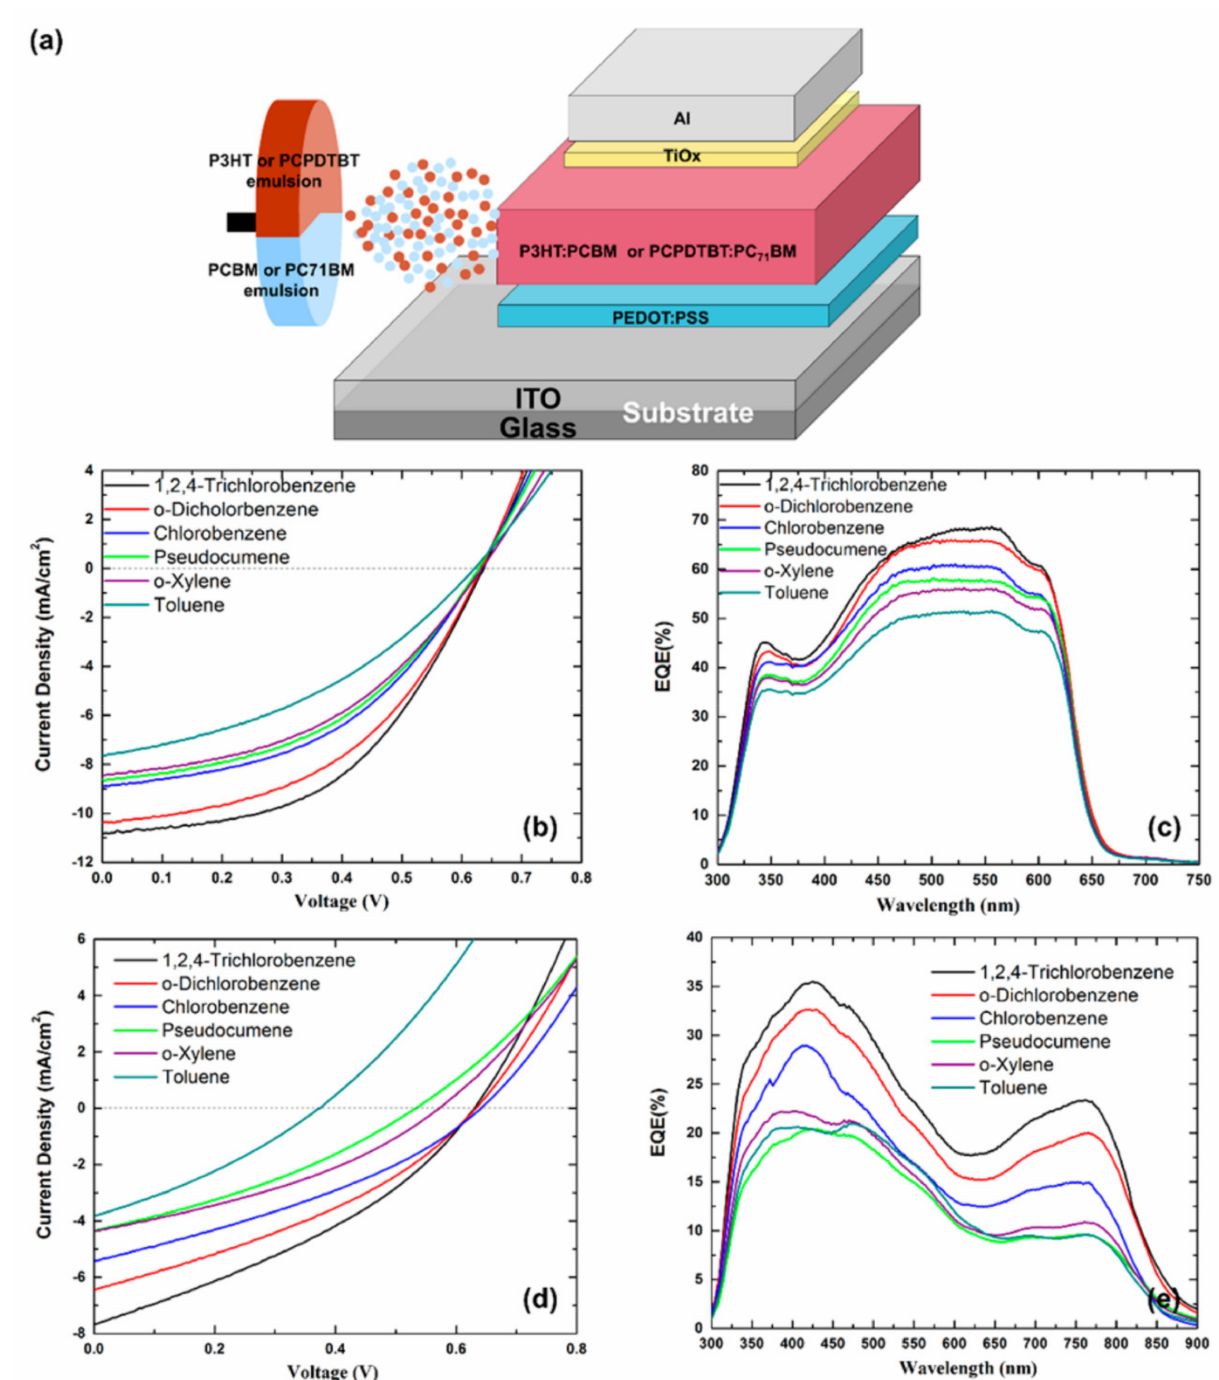
Figure 8. ( a ) Schematic representation of the target used in the preparation of the organic active films based on P3HT:PC61BM or PCPDTBT:PC71BM and the solar cell fabricated with them. ( b ) J − V characteristics and ( c ) EQE spectra of P3HT:PC61BM solar cells. ( d ) J − V characteristics and ( e ) EQE spectra of PCPDTBT:PC71BM solar cells. Reprinted with permission from [70]. Copyright 2016 American Chemical